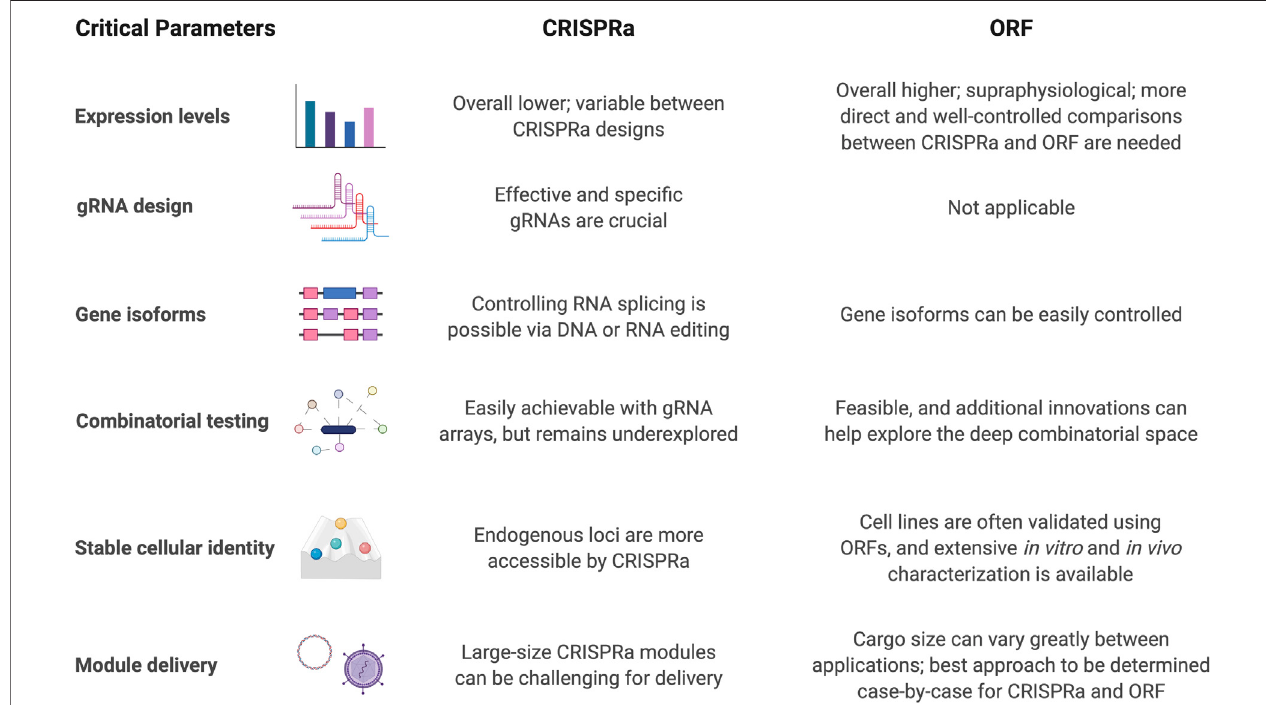
FIGURE 3 | Critical parameters to consider for CRISPRa and ORF-based differentiation strategies.